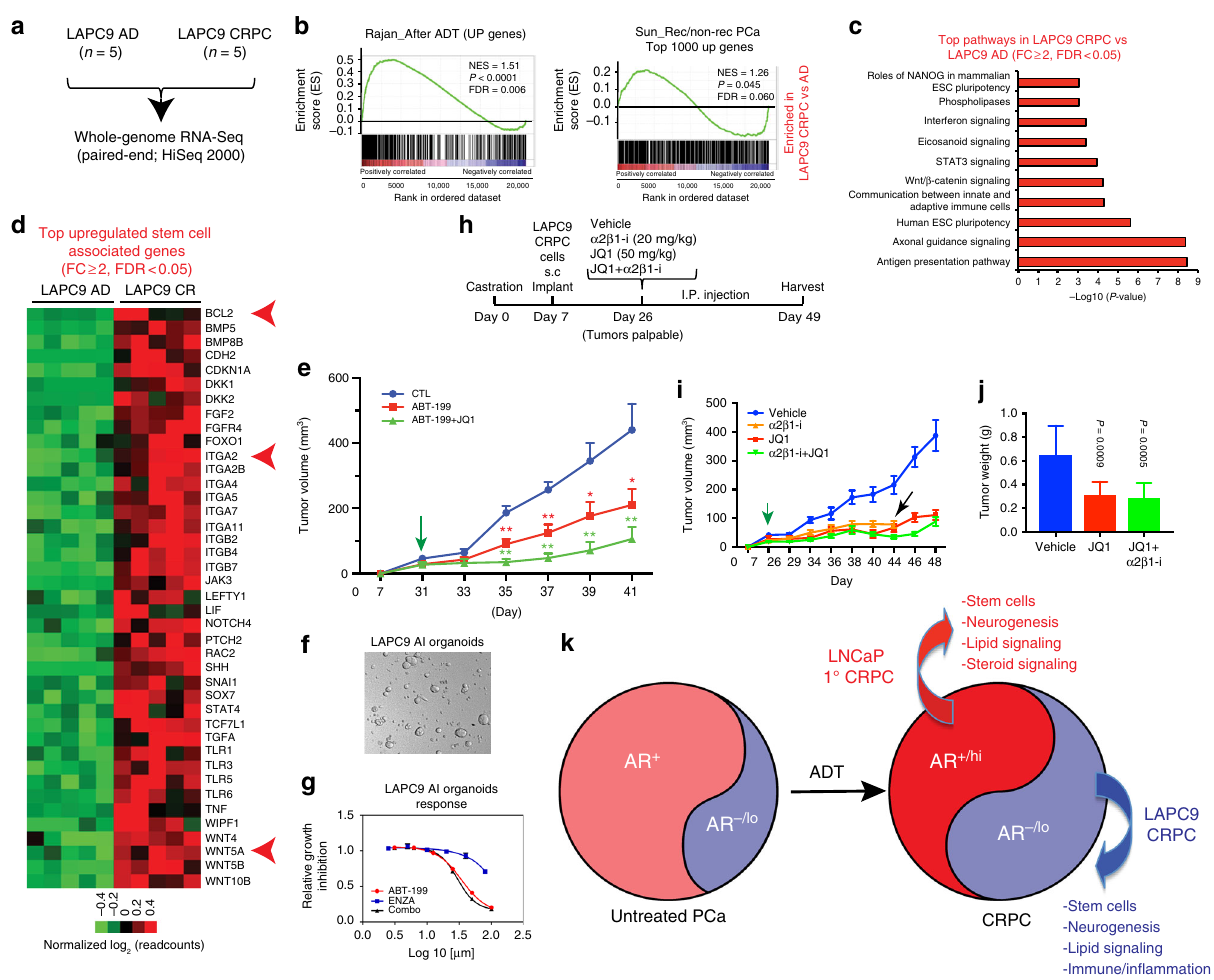
Fig. 8 Novel mechanisms and therapeutic strategies in AR − /lo LAPC9 CRPC. a Experimental scheme of RNA-Seq in LAPC9 models. b GSEA showing that LAPC9 CRPC is enriched in gene sets preferentially expressed in ADT-resistant patient CRPC 22,23 . c IPA biological function pro fi ling of 3929 DEGs (FC ≥ 2, FDR < 0.05) in LAPC9 CRPC tumors ( n = 5) relative to AD tumors ( n = 5). Shown are selected top pathways. d Heat map showing representative stem cell genes upregulated in LAPC9 CRPC compared to AD tumors. Three representative genes are indicated by a red arrow. e Therapeutic targeting of AR − /lo LAPC9 CRPC using ABT-199 alone or ABT-199 combined with JQ1 (see also Supplementary Fig. 19f). * P < 0.05; ** P < 0.01 (Student ’ s t -test; mean ± SD). f , g BCL-2 inhibitor ABT-199 inhibits LAPC9 organoid growth. Shown are a representative phase contrast image of the LAPC9 CRPC (AI) organoids ( f ) and growth curves of LAPC9 organoids in response to treatments ( g ). Note identical responses to ABT-199 and ABT-199 plus Enza ( g ). h – j Targeting stem cell molecules integrin α 2 β 1 and c-Myc inhibits LAPC9 CRPC growth. Shown are the experimental scheme ( h ), tumor growth curves ( i ) and endpoint tumor weights ( j ). In h, the doses of inhibitors for α 2 β 1 (i.e., α 2 β 1-i) and for BET bromodomain proteins including c-Myc (i.e., JQ1) are indicated. For i, the green arrow indicates the time (day 26) when drug treatment was initiated and the black arrow indicates the time when the α 2 β 1-i ran out (and thus this treatment was stopped on day 44). The differences in tumor volumes between treatment groups vs. vehicle control group were all statistically signi fi cant ( P < 0.01; Student ’ s t -test) starting from day 29. Error bars represent the mean ± S.D. For j , P values for tumor weights were determined by comparing with the vehicle control group (Student ’ s t -test; mean ± SD). k A model depicting dynamic changes in AR + and AR − /lo PCa cells in response to ADT (castration and anti-AR therapeutics). AR heterogeneity becomes accentuated in CRPC manifested by the emergence of AR + /hi cells (illustrated by deeper red color) due to AR overexpression (e.g., genomic ampli fi cation of the AR gene and epigenetic alterations), as well as expansion of the AR − /lo PCa cell